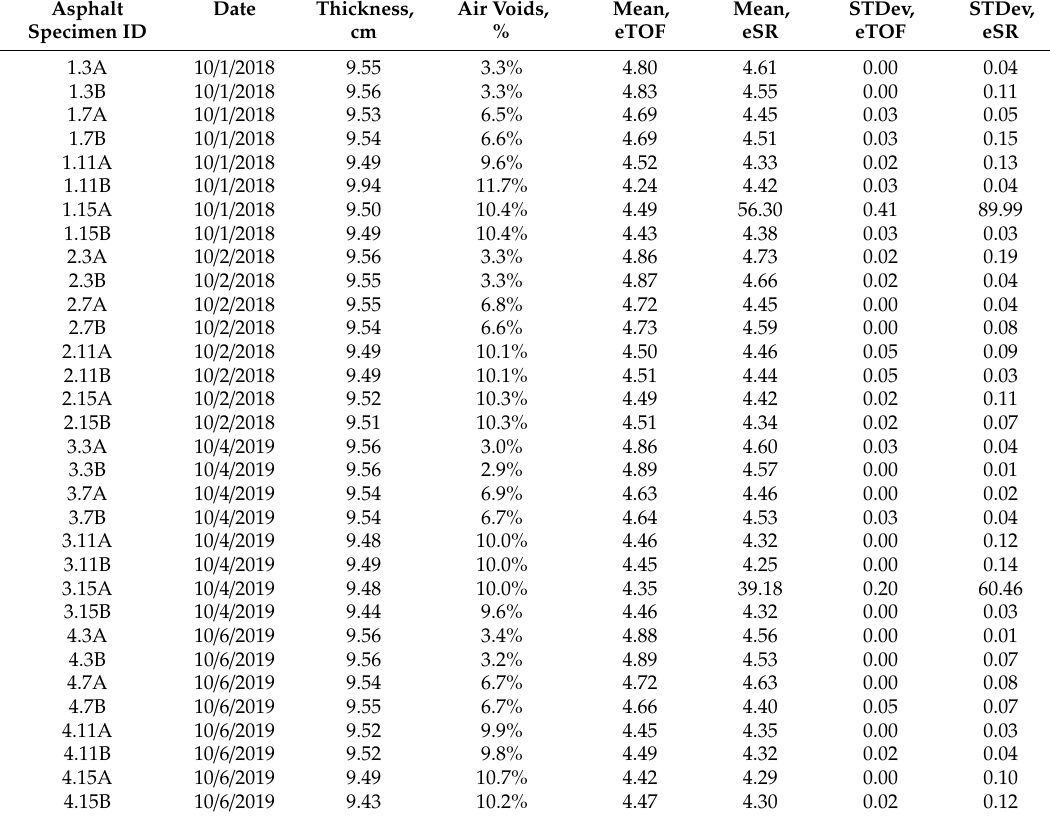
Table 1. Information about Highway 371 asphalt specimens and dielectric